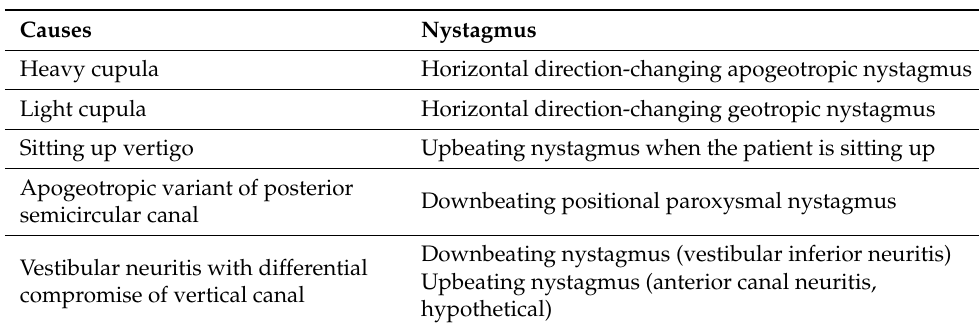
Table 3. Probable APV